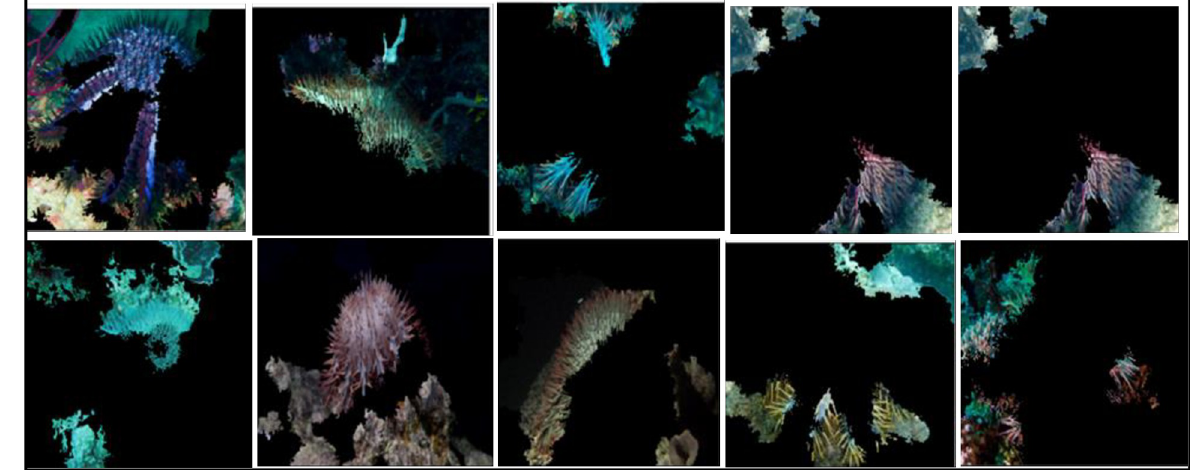
Fig 12. Images after the application of the attention